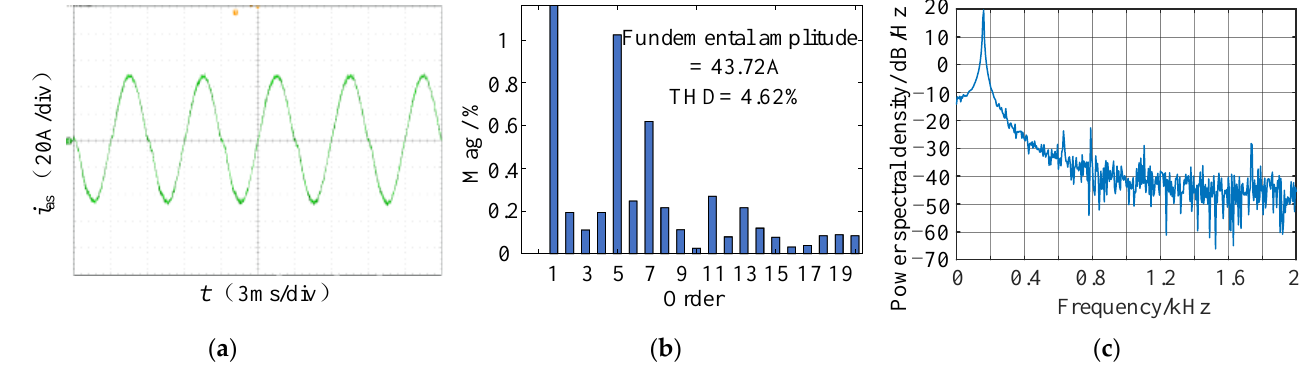
Figure 25. Experimental results under 6th harmonic controller. ( a ) i as ; ( b ) FFT; and ( c ) power spectral density.